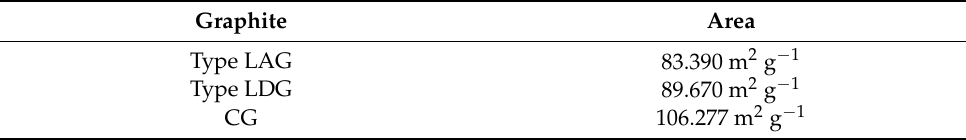
Table 1. Surface area determined by Brunauer-Emmett-Teller (BET) analysis of the graphite morphologies.